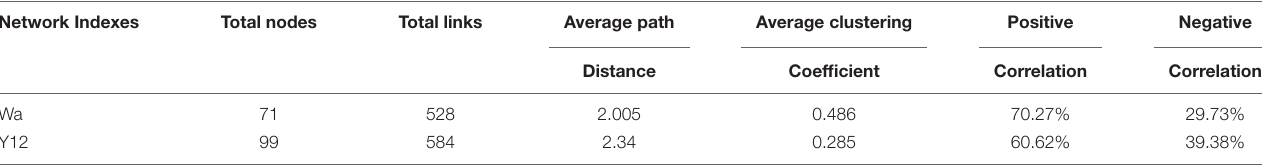
TABLE 2 | Co-occurrence network indices of different groups.